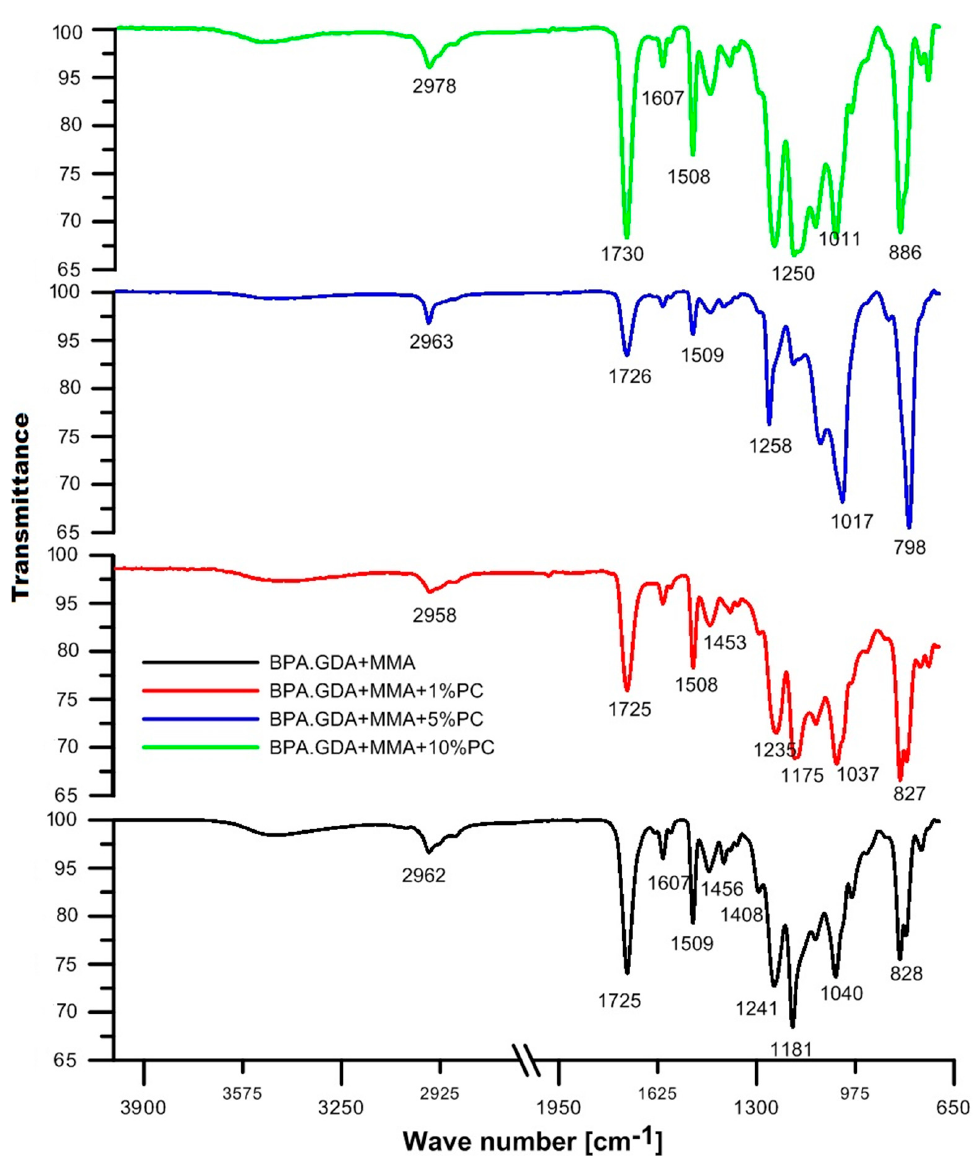
Figure 3. Attenuated total reflection–Fourier transform infrared (ATR/FT-IR) spectra of bisphenol A glycerolate diacrylate (BPA.GDA) + MMA derived blend.